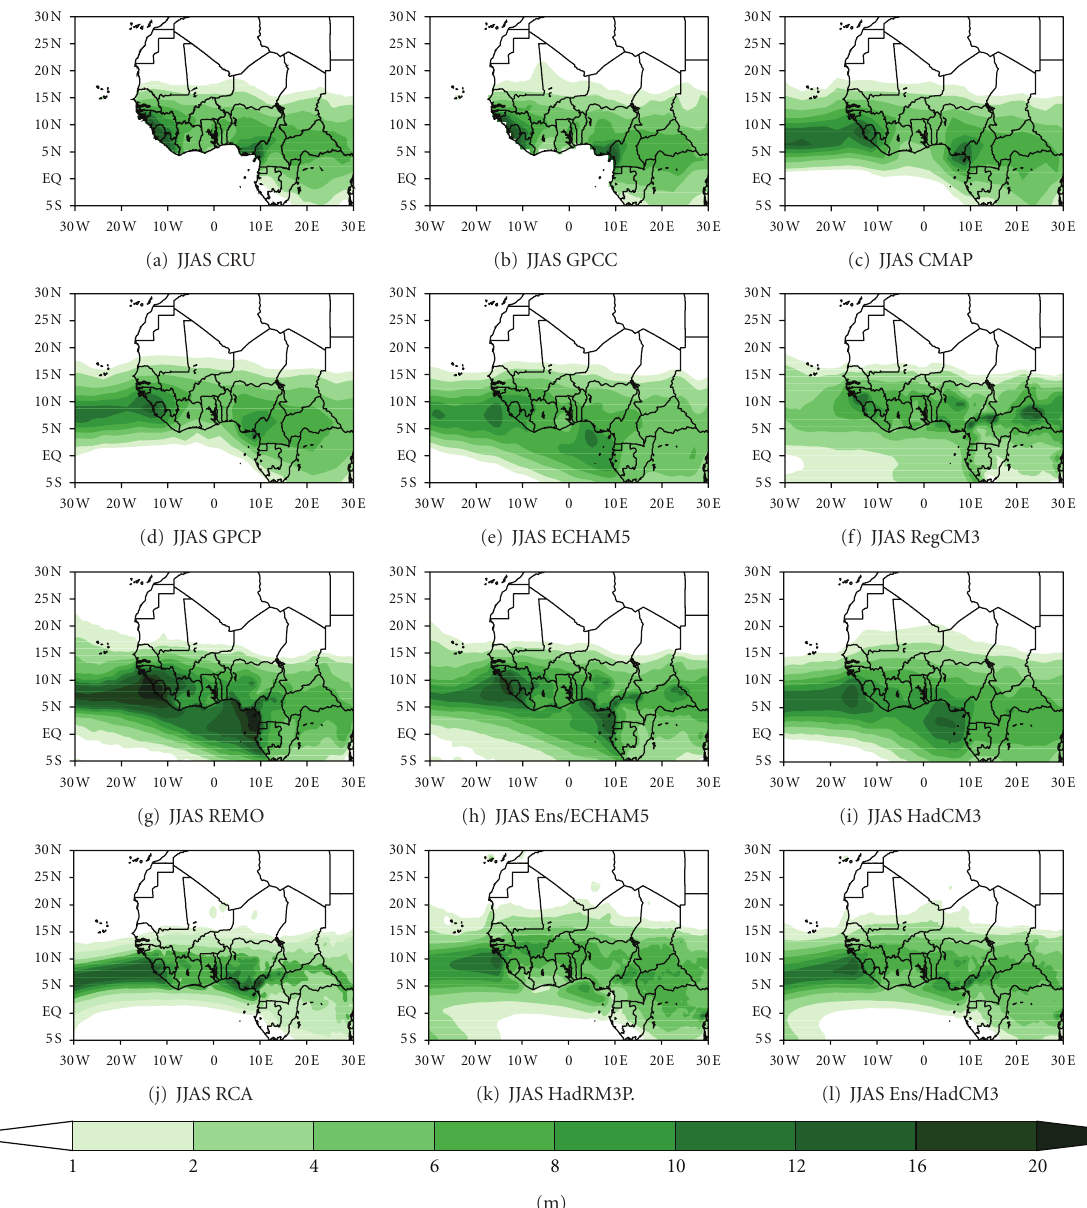
Figure 4: 1981–2000 averaged JJAS of precipitation (in mm/day) from: (a) CRU observation, (b) GPCC observation, (c) CMAP observation, (d) GPCP observation, (e) ECHAM5, (f) RegCM3, (g) REMO, (h) Ens/CHAM5 (ensemble mean of RCMs driven by ECHAM5), (i) HadCM3, (j) RCA, (k) HadRM3P, and (l) Ens/HadCM3 (ensemble mean of RCMs driven by HadCM3).